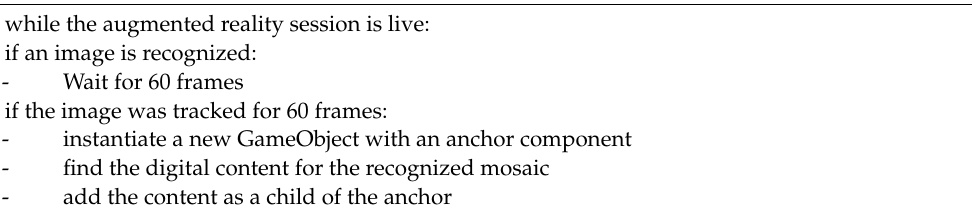
Algorithm 1 Description of the image recognition and insertion of the AR experience.